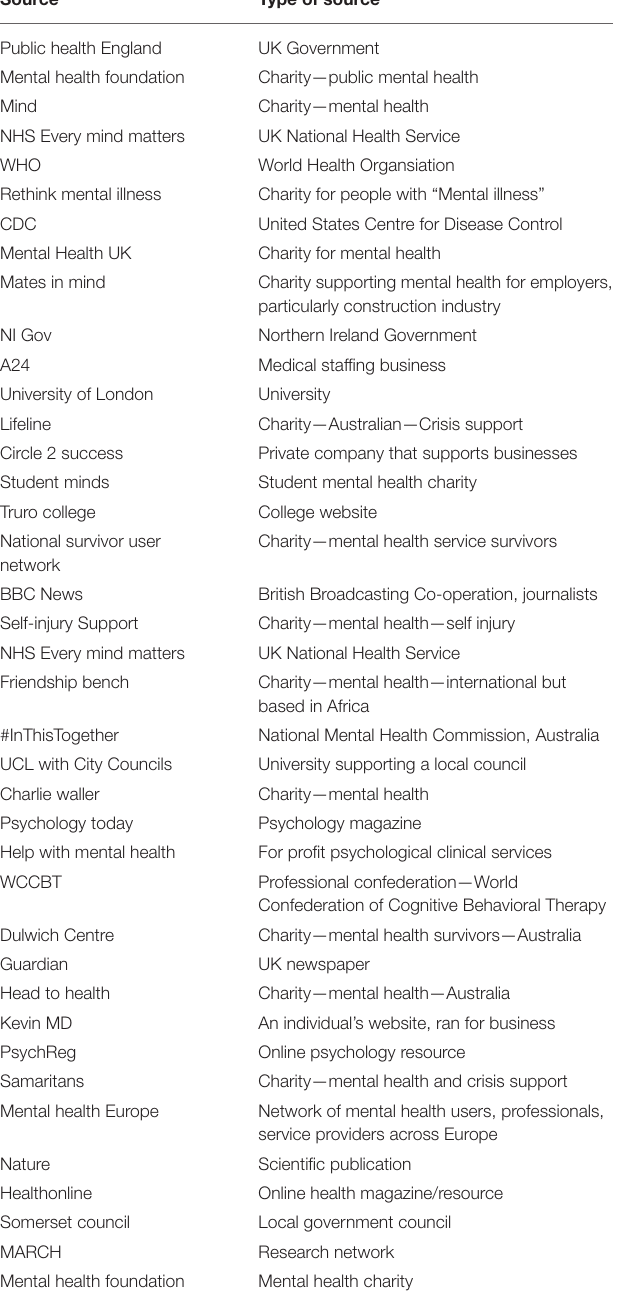
TABLE 1 | Lists the organizations that produced the resources. TABLE 2 | Content of COVID-19 mental health focused online resources.